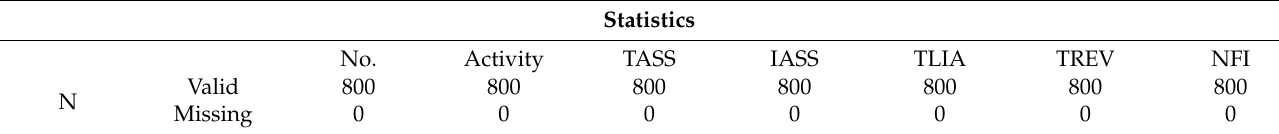
Table 1. Descriptive analysis of the number of the investigated businesses.